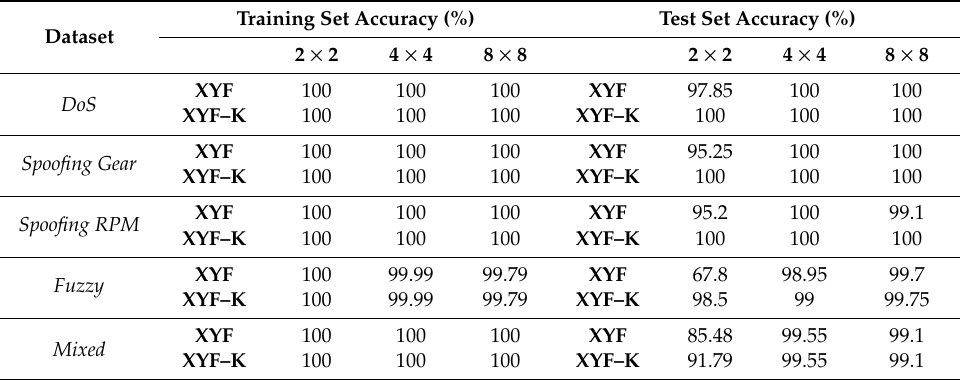
Table 5. XYF Kohonen network and XYF–K algorithm accuracy.